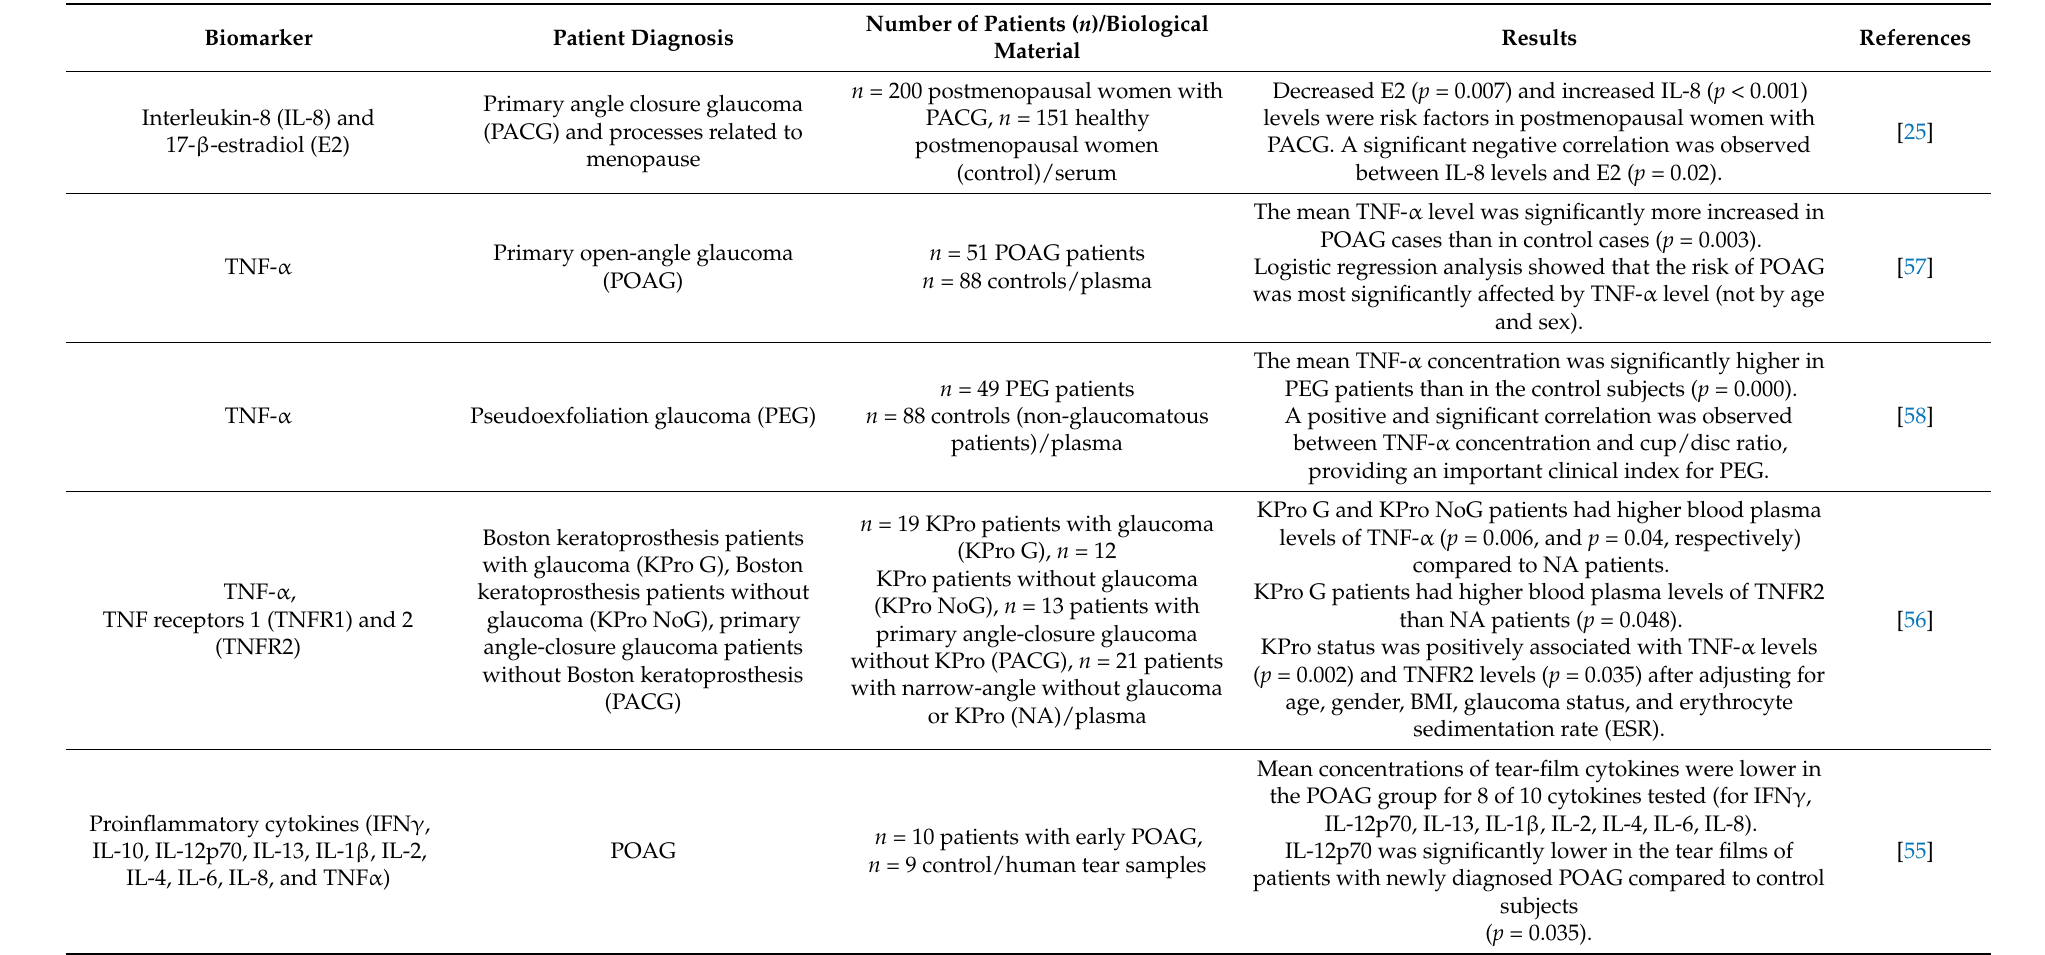
Table 3. Cytokines and growth factors evaluated as potential biomarkers in